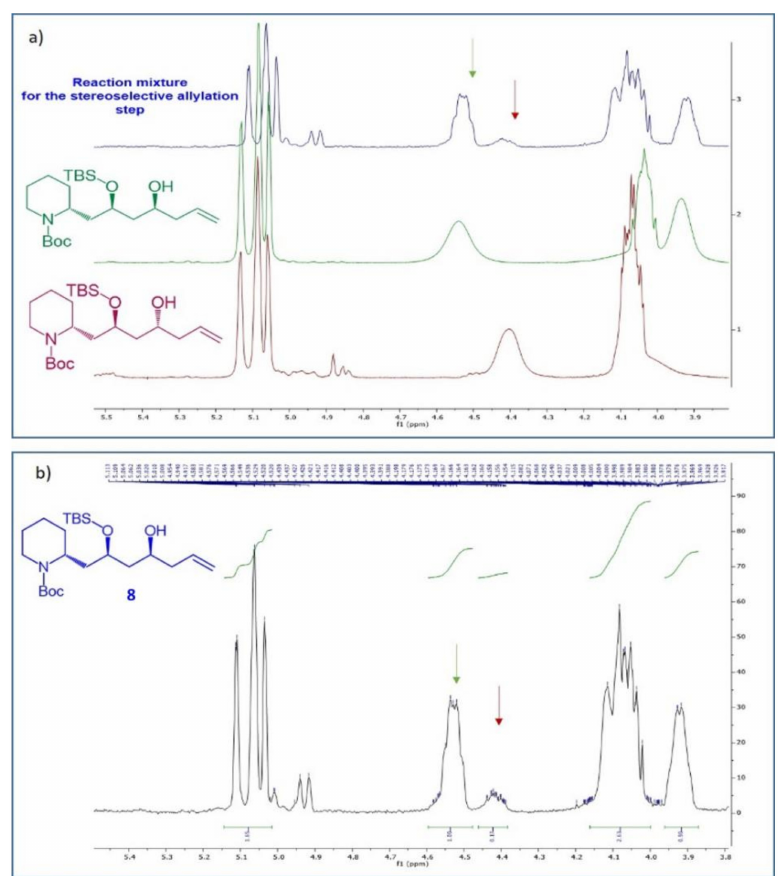
Figure 4. 1 H-NMR determination of the d.r. for the asymmetric allylation of aldehyde 7 (400 MHz, deuterated benzene). ( a ) 1 H-NMR spectra of the reaction mixture for the asymmetric allylation (in blue) and of the two single diastereomers 8 and 8b (green and red). In the first spectrum the presence of a major and a minor diastereomers is appreciable, as indicated by the two arrows. ( b ) elaboration of the blue spectrum of Figure 4a, showing the integrals exploited for the d.r.